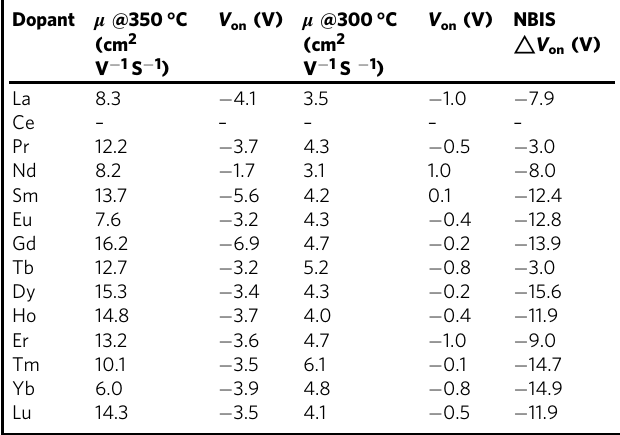
Table 1 Summary for the performance of TFTs with Ln:In 2 O 3